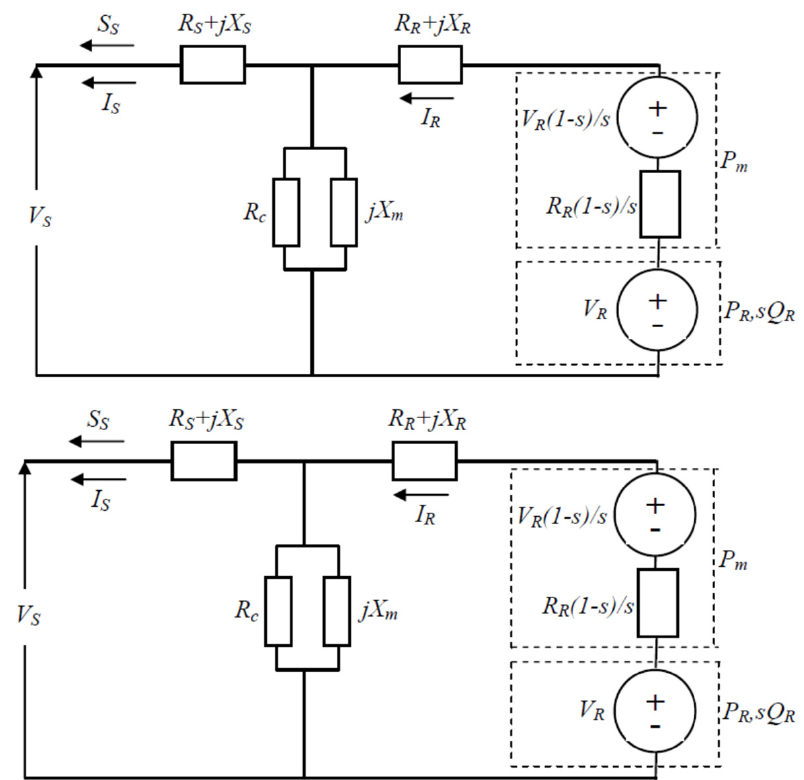
Figure 4. Modified equivalent circuits of WRIG.